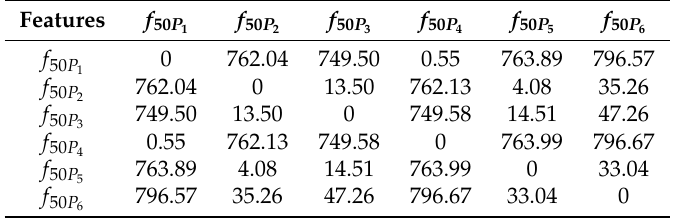
Table 5. Euclidean Distance Matrix Calculated for Selected Features (Table 2) for 50 Hz Power ENF Signals.